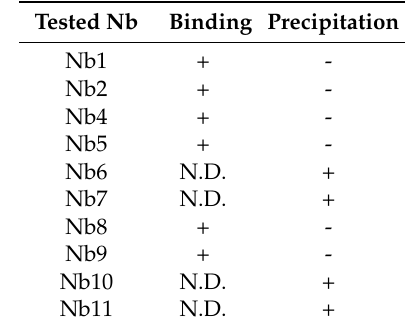
Figure 6. SsZntA-Nb complex analysis using size-exclusion chromatography. ( a ) Black line: Chromatogram of SsZntA (40 µ M) incubated with Nb1 (100 µ M) in a final volume of 50 µ L (then diluted to 500 µ M) and run through a size-exclusion column (Superose6, 1 CV = 24 mL) showing a peak at 0.6 CV, which contains the SsZntA-Nb complex, and a peak at 0.85 CV, which contains unbound Nb. The dashed line represents the chromatogram of Nb1 alone, while the dotted line the one from SsZntA alone (under the same condition). ( b ) Coomassie-stained SDS-PAGE gel of the fractions collected at 0.35, 0.5, 0.55, 0.6, 0.65, 0.8, 0.85, 0.9, 1 CV. Table 1. Size-exclusion chromatography co-elution results.